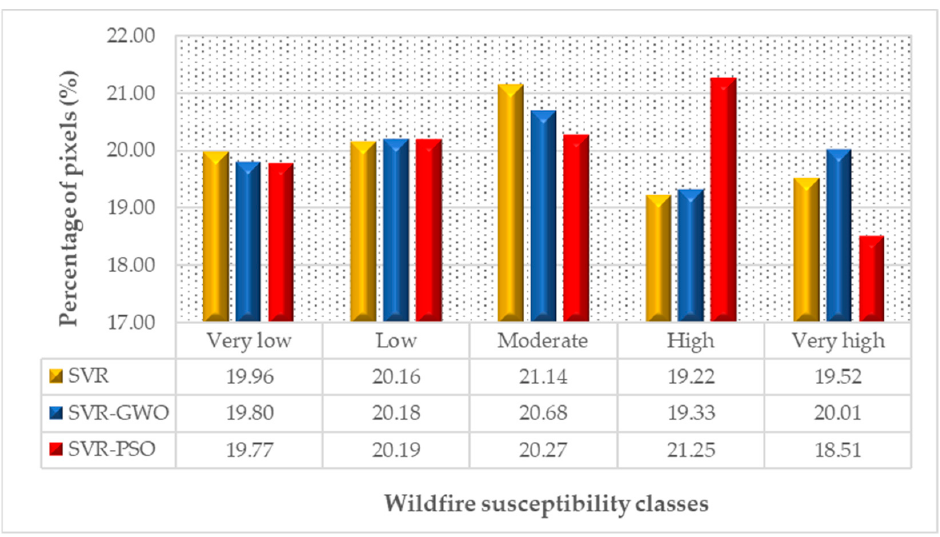
Figure 9. Percentage of wildfire susceptibility classes in the SVR, SVR-GWO, and SVR-PSO maps.